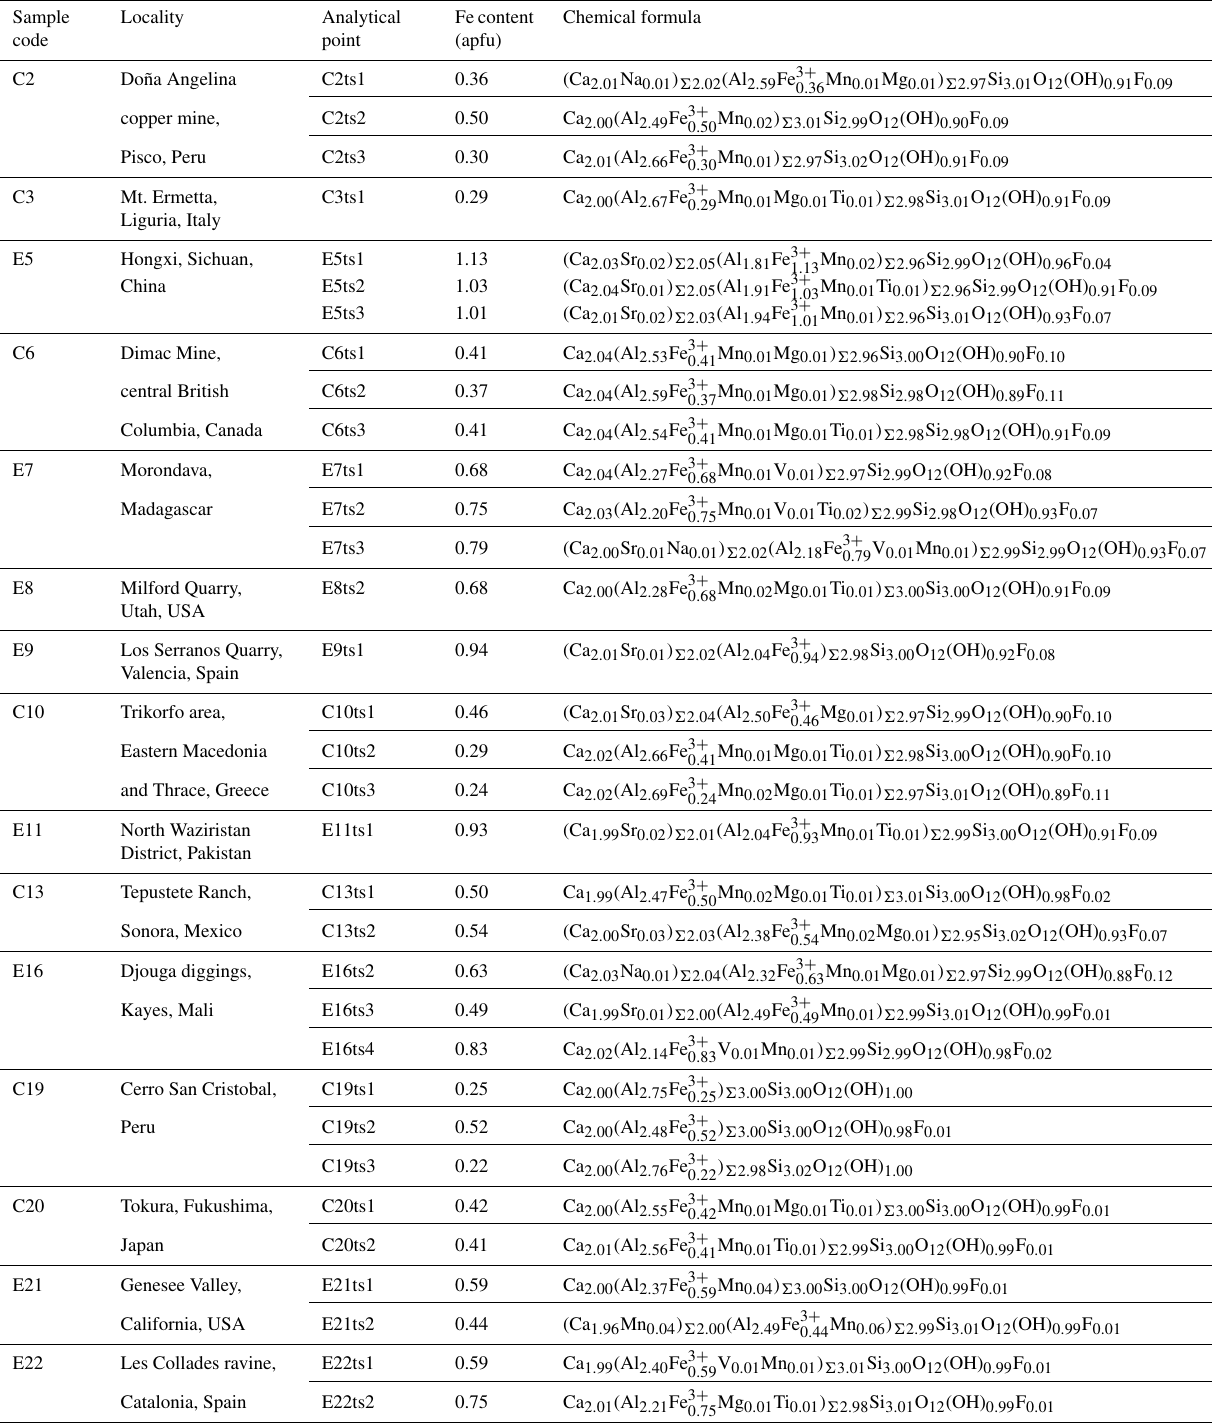
Table 2. Sample localities and chemical formulae of each analytical point. Sample